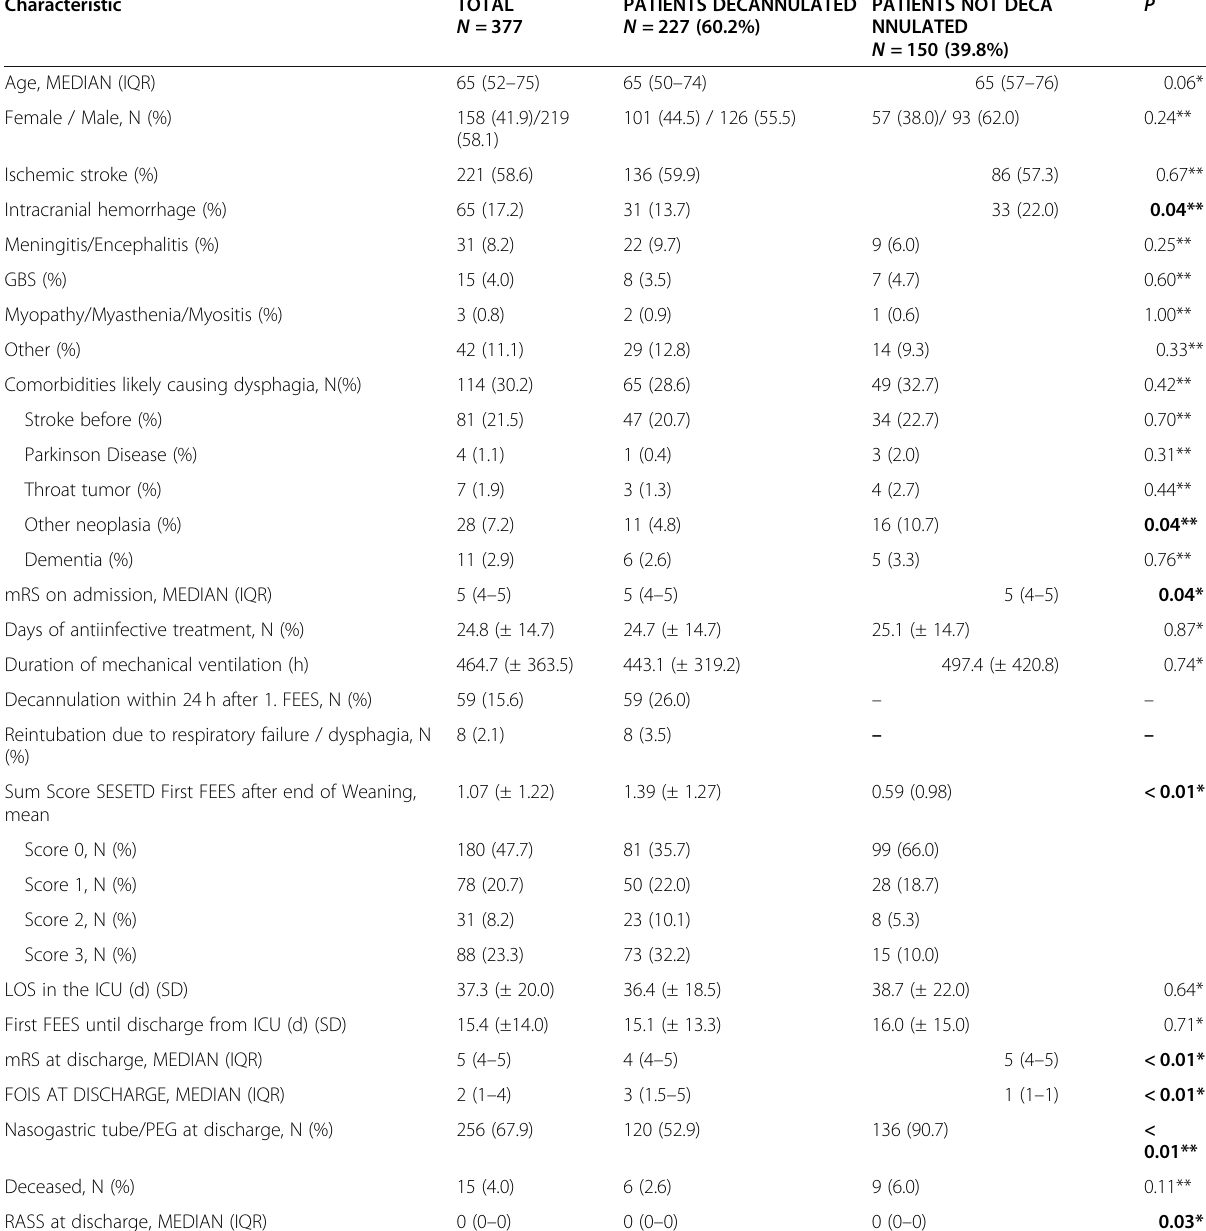
Table 1 Basic patient characteristics and outcome parameters depending on variable decannulated / not decannulated (IQR = interquartile range; GBS = Guillain Barré syndrome; h = hours; d = days; mRS = modified Rankin Scale; GCS = Glasgow Coma Scale; LOS = length of stay; ICU = intensive care unit; FOIS = Functional Oral Intake Scale; RASS = Richmond Agitation and Sedation Scale); * Mann-Whitney U-test ** Chi 2 / Fisher-exact